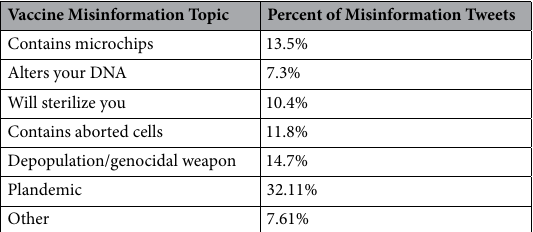
Vaccine Misinformation